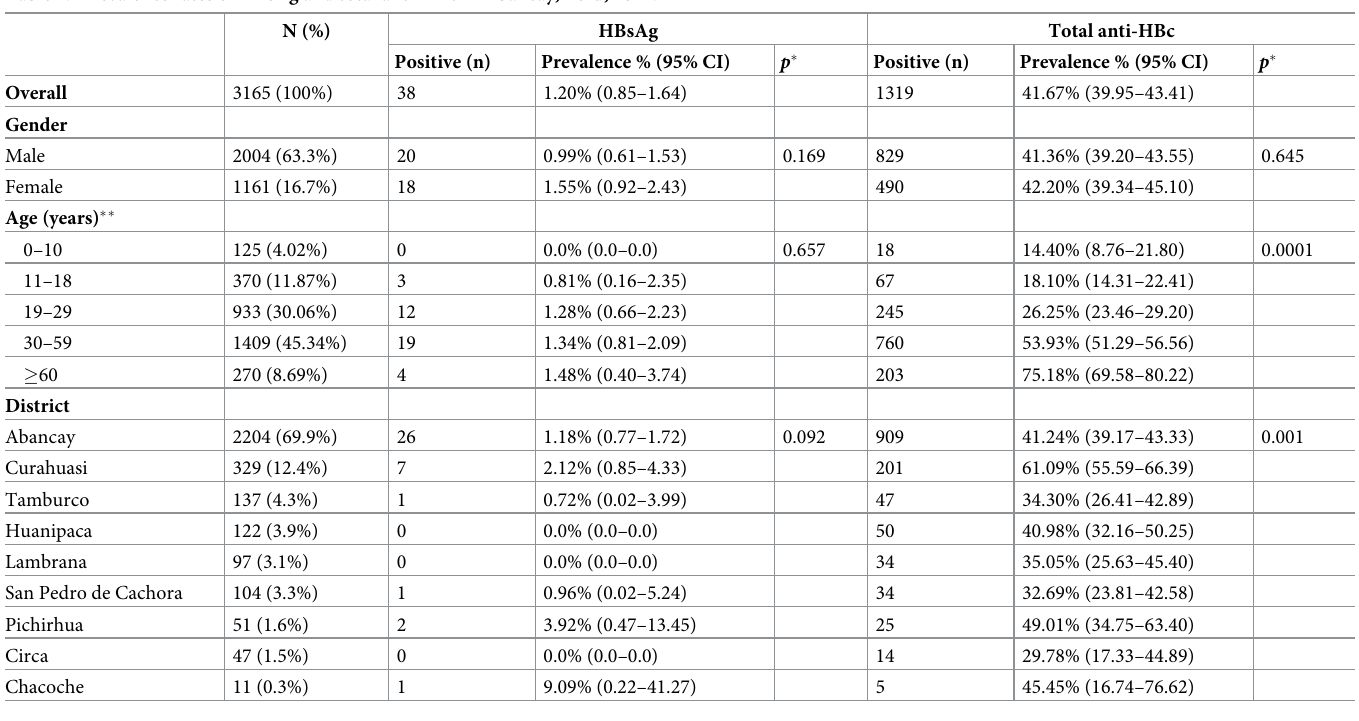
Table 1. Prevalence rates of HBsAg and total anti-HBc in Abancay, Peru, 2014. N